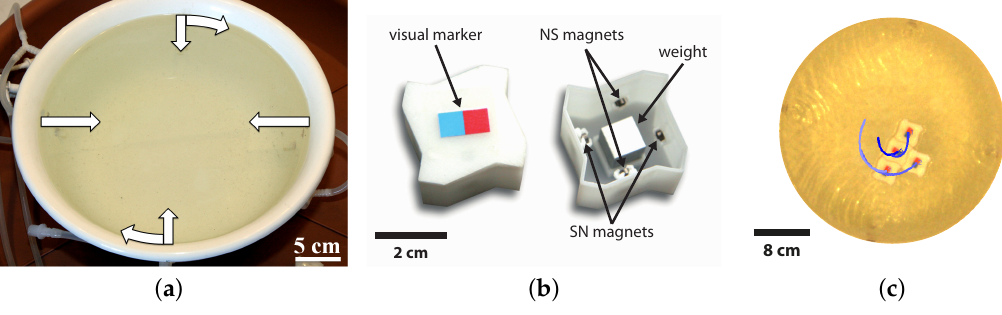
Figure 1. The experimental setup: ( a ) water-filled tank with six inlets (four orthogonal and two tangential to the wall); ( b ) details of a floating passive Lily module, including the latching mechanism composed of four permanent magnets with different pole orientation North-South (NS) and South-North (SN), respectively; ( c ) real-time visual tracking of four modules during an experiment (the blue lines show a short history of the trajectory of each module)